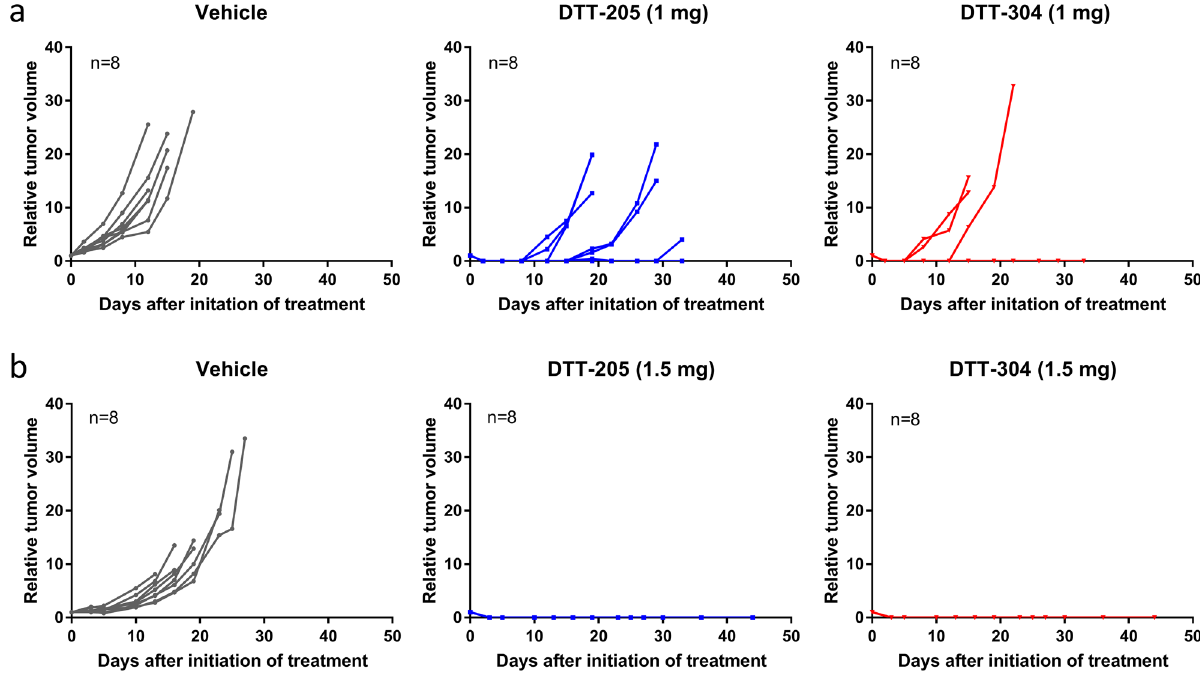
Figure 1. Response to DTT-205 or DTT-304 treatment in CT26 tumors. ( a ) Tumor growth curves of CT26 tumors treated with vehicle, 1 mg DTT-205 or 1 mg DTT-304. Tumors were treated for three consecutive days. ( b ) Tumor growth curves of CT26 tumors treated with vehicle, 1.5 mg DTT-205 or 1.5 mg DTT-304 for four consecutive